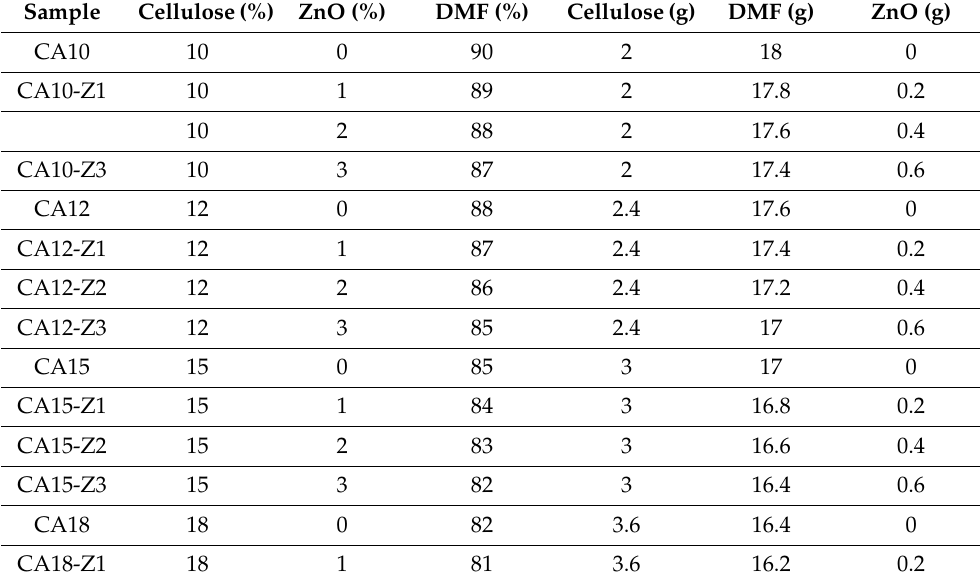
Table 2. Membrane